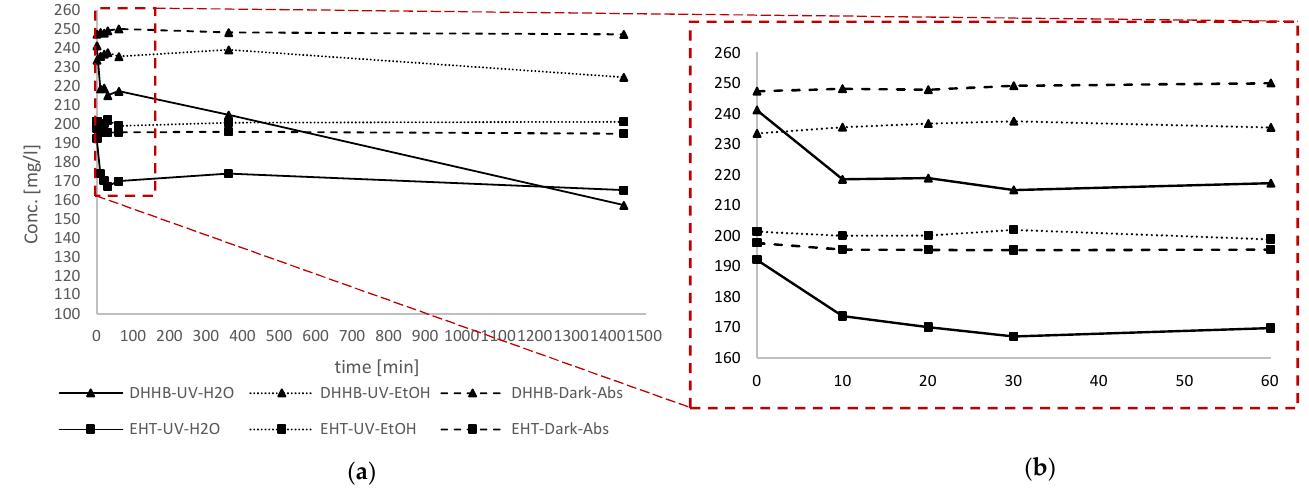
Figure 10. Trend of DHHB and ETH concentration under three different conditions. Irradiation in aqueous solvent with HPS as solubilizer, irradiation in organic solvent (EtOH) and adsorption without irradiation in aqueous solvent with solubilizer. ZnO with a higher surface area (30 m 2 /g) was used for this analysis. ( a ) general trend in 24h, (b) focus from t 0 to 60 minutes.